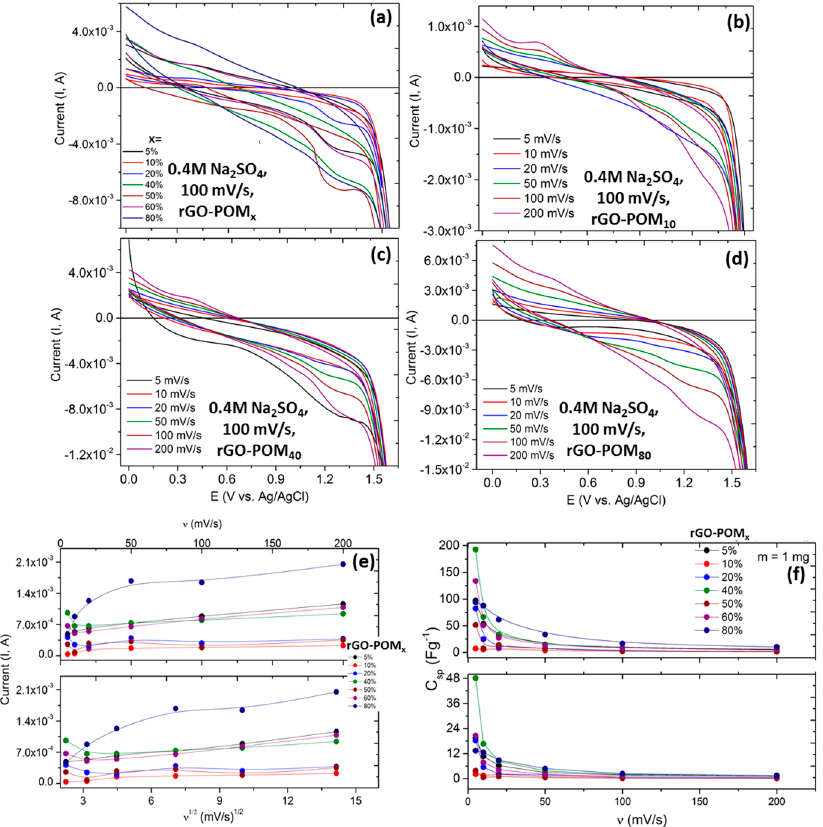
Figure 2. ( a – d ) Cyclic voltammery (CV) curves measured in 0.4 M Na 2 SO 4 showing pseudocapacitive behavior with x (10, 40 and 80 wt %) and scan rate ( v = 5, 10, 20, 50, 100 and 200 mV/s); ( e ) current versus square root scan rate showing quasi-linear behavior; and ( f ) gravimetric specific capacitance ( C sp ; F · g − 1 ) with scan rate for rGO–POM x -based hybrid series ( x = 5, 10, 20, 40, 50, 60 and 80 wt %).